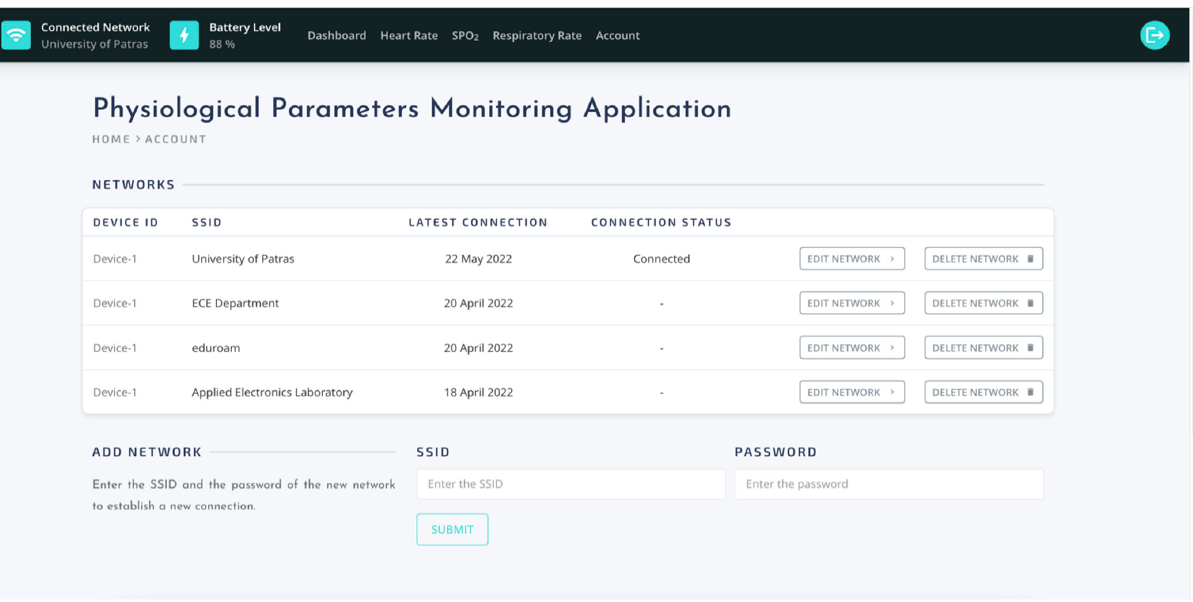
Figure 13. The UI of user account page.